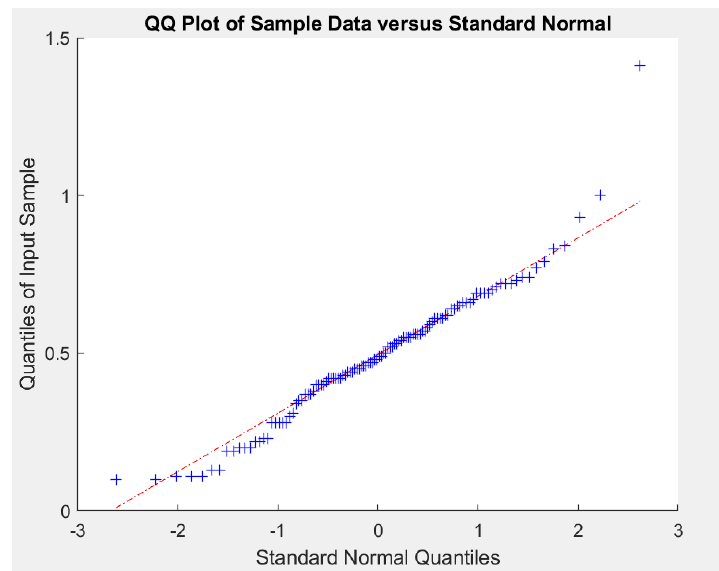
Figure 2. Q–Q (Quantile) graph of classification index data.